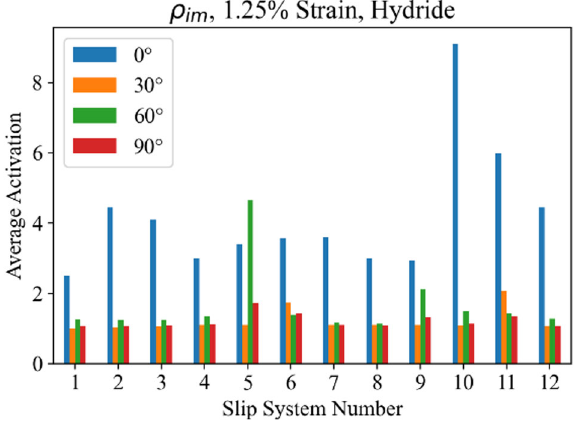
Fig. 24 Average immobile slip system activation for hydride material (fcc) at 2.0% nominal strain.